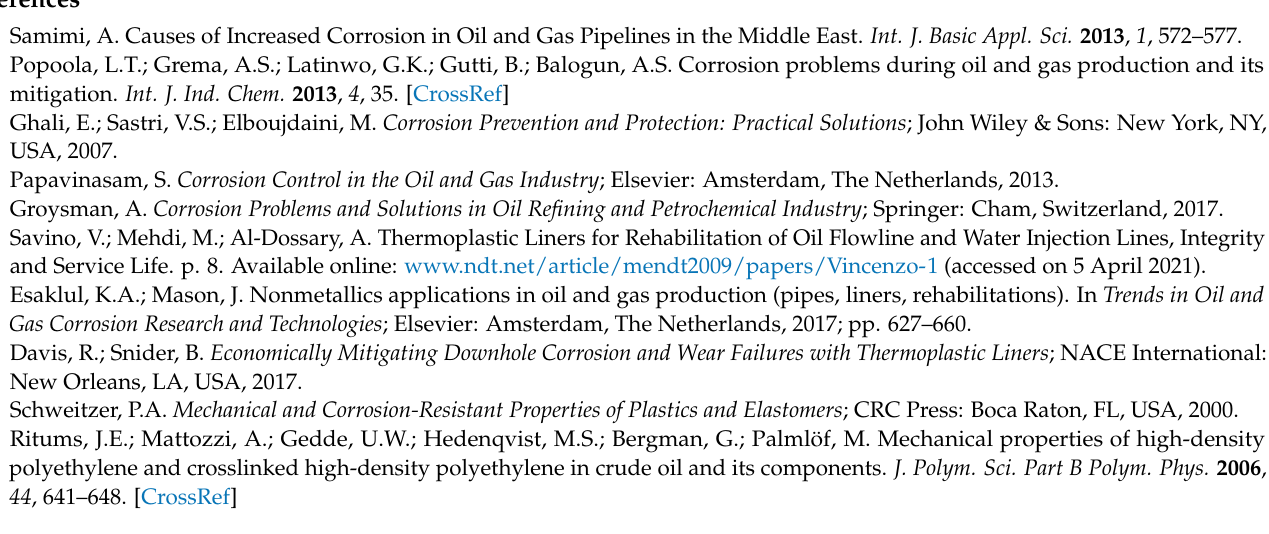
Figure A4. T g of HDPE after Experiment 3.